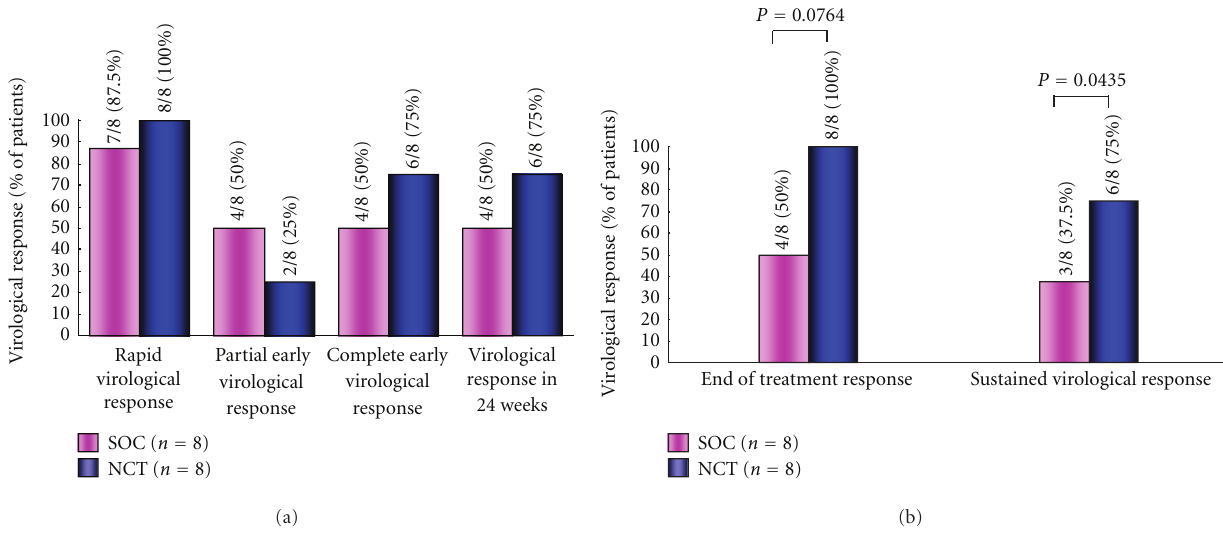
Figure 11: Rate of early viral responses in the initial 4 and 12 weeks (a) and end-of-treatment virological response and sustained virological response (b) in chronic hepatitis C patients with genotype 1 and high viral loads treated with the NCT and the SOC according to intention to treat. NCT: novel combination treatment; cyclic and periodic IFN treatment (CPIT) consisting of induction treatment with natural interferon- β followed by maintenance treatment with natural interferon- α for 24 wks as induction approach followed by SOC for 48wks. SOC: standard of care; ribavirin plus pegylated interferon α 2b for 48 wks.